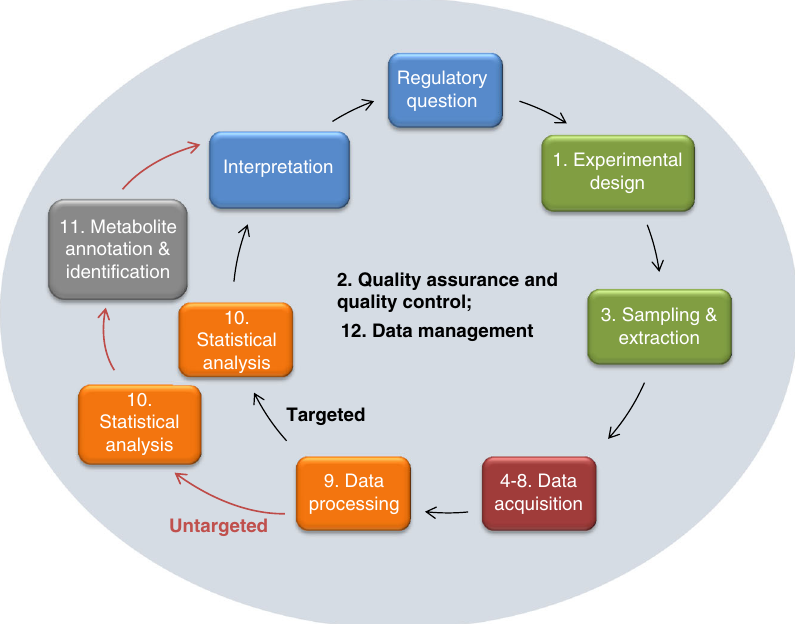
Fig. 3 Overall work fl ows for untargeted metabolomics and targeted metabolite analyses. A further approach called semi-targeted analysis represents a hybrid of targeted and untargeted assays. Numbers refer to the Supplementary Notes that describe each section of the work fl